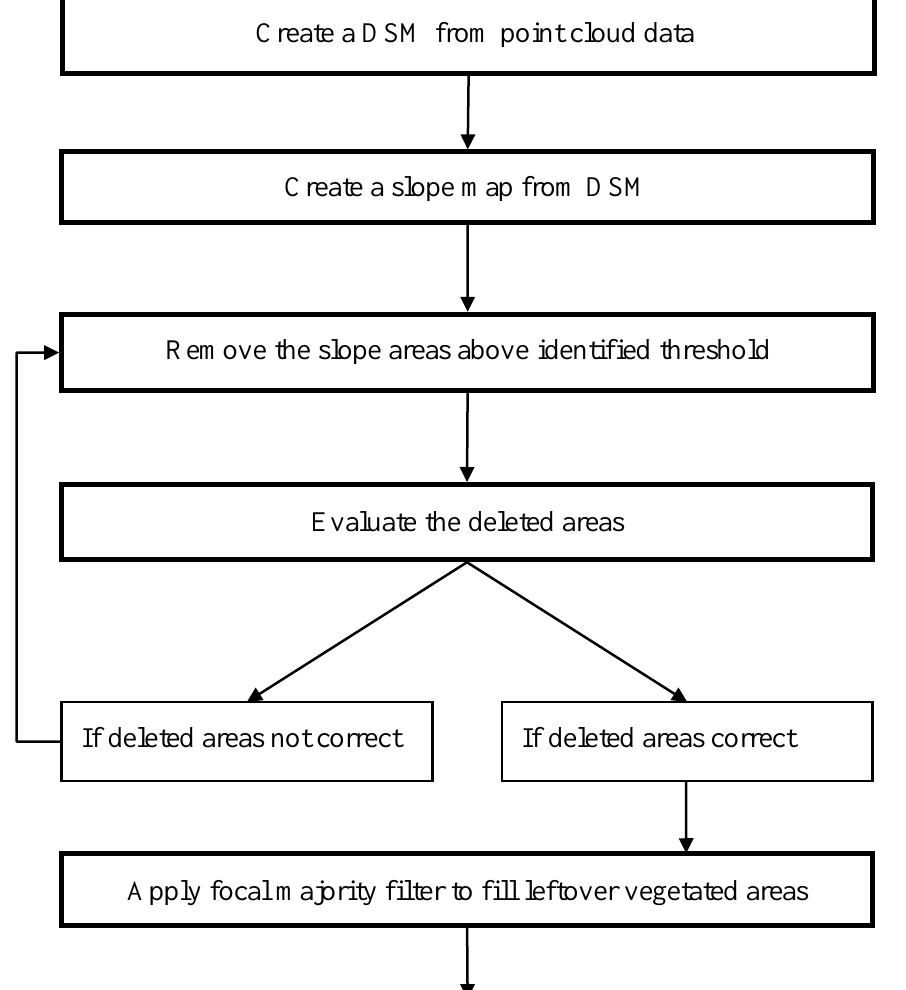
Figure 2. Flow diagram showing steps used to remove vegetation from